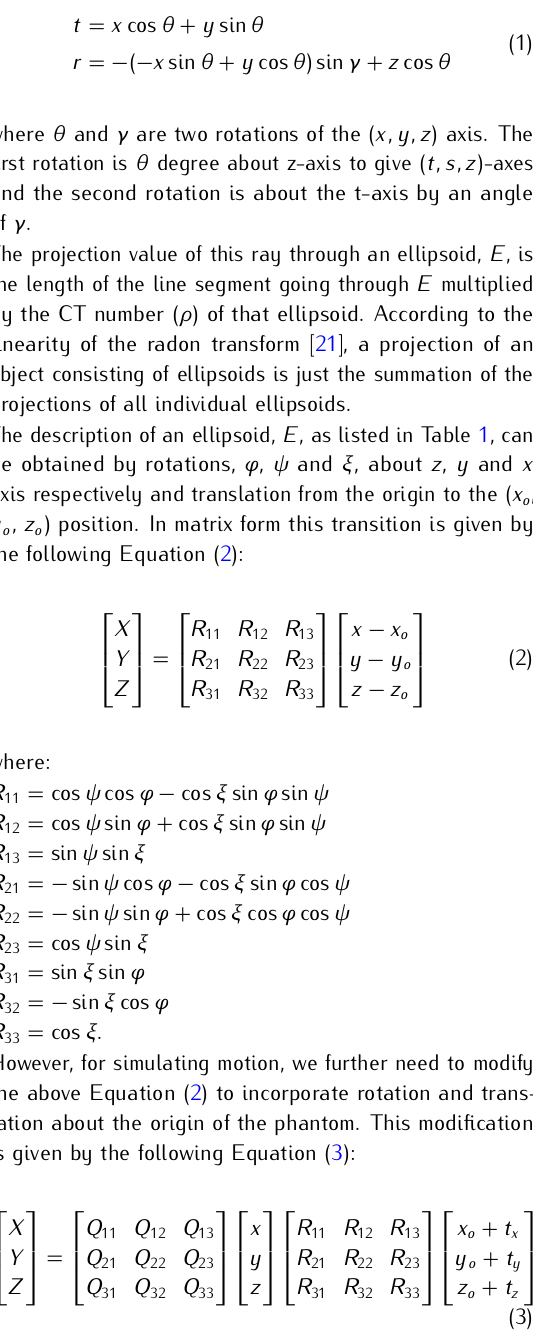
Table 1. Parameters of the modified 3D Shepp-Logan phantom. Center